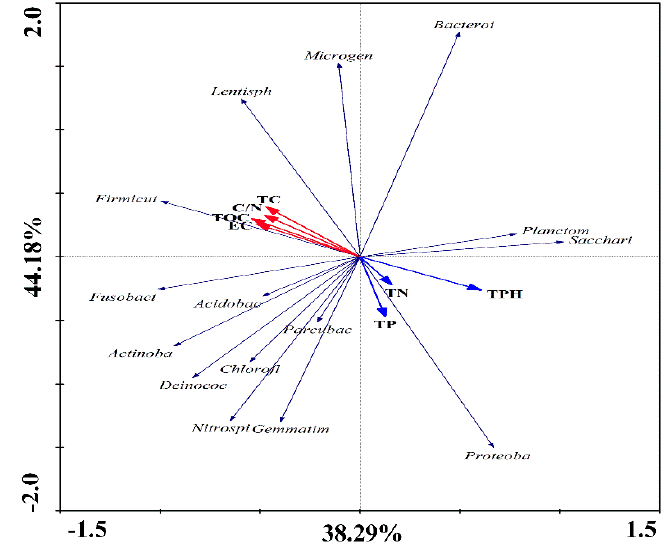
Figure 6. Correlation between bacterial community structure and environmental factors.